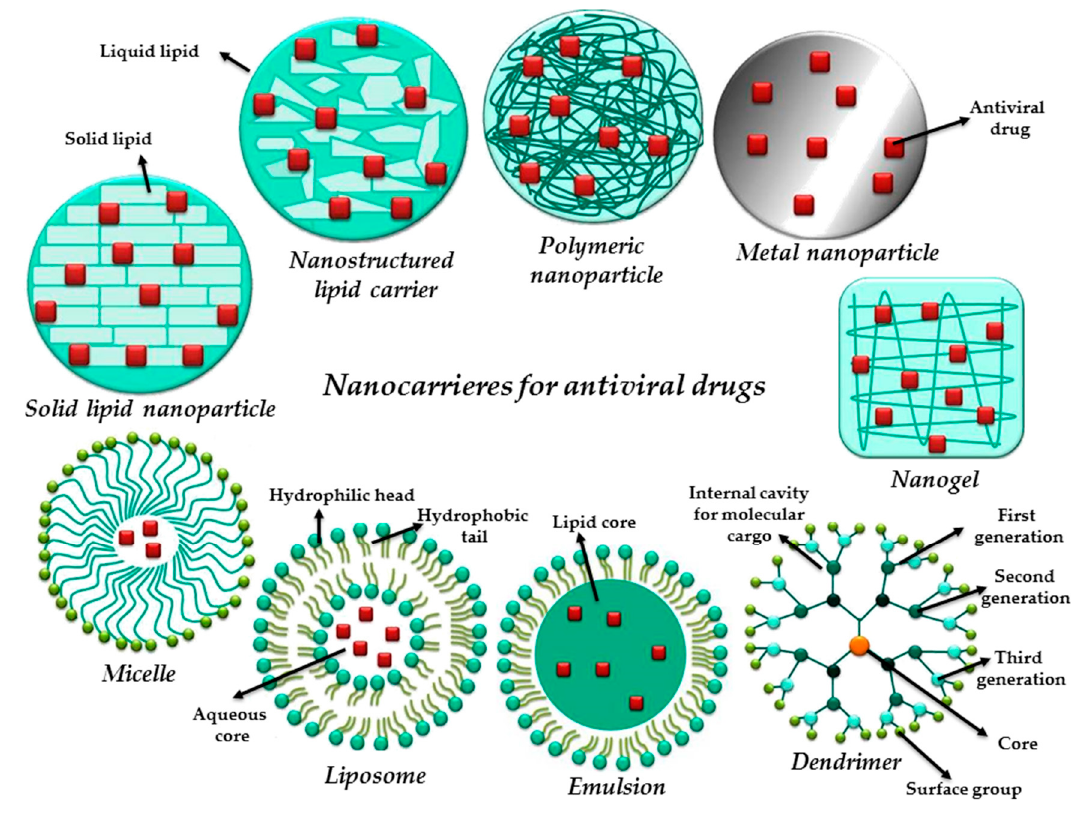
Figure 4. Nanocarriers developed for antiviral therapy.